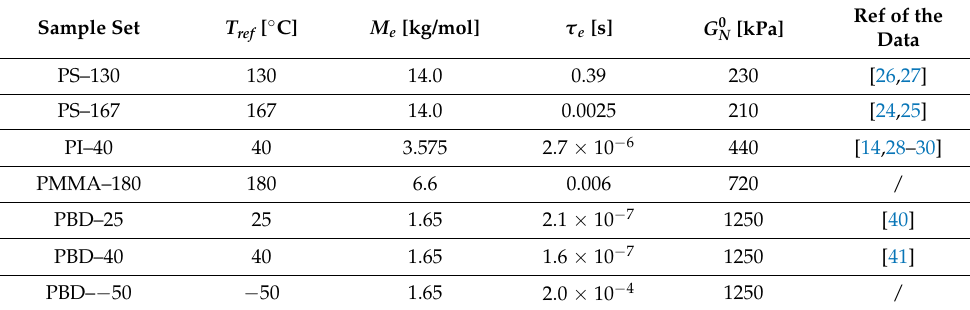
Table 7. Material parameters for the data